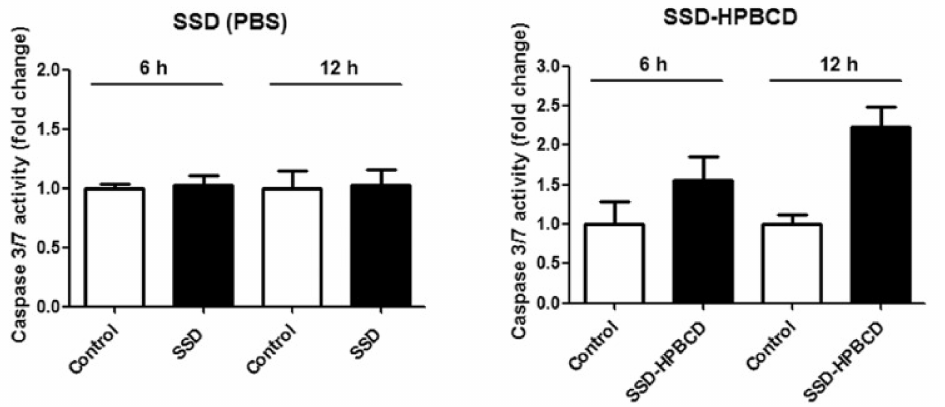
Figure 10. Effects of 2.5 µ M pure saikosaponin-d (SSD) and SSD–HP– β -CD on HSC-1 cell apoptosis at 6 and 12 h